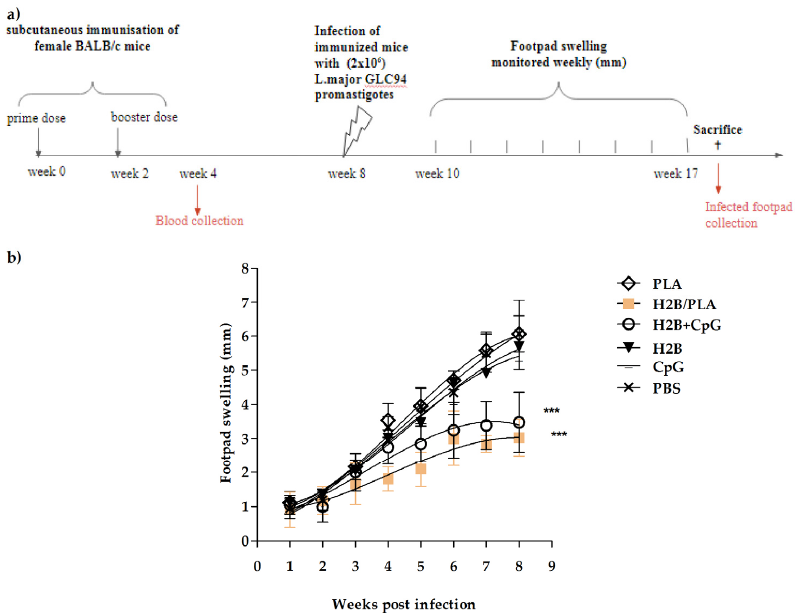
Figure 7. Immune protection of vaccinated BALB/c mice against Leishmania major challenge. ( a ) The timeline of the in vivo experiment. Female BALB/c mice (6–8 weeks old) were vaccinated twice on day 1 and day 14 with H2B/PLA (25 µg/protein), H2B (25 µg) + CpG or soluble H2B (25 µg). The control groups received PBS, PLANPs or CpG. Mice were infected with (2 × 10 6 ) L. major GLC94 promastigotes by subcutaneous injection on the right footpad. ( b ) Footpad swelling. Lesion sizes were monitored weekly for up to eight weeks. The mean lesion size ± SD is shown ( n = 8). (***) p < 0.001 between PBS control and protein-received groups.